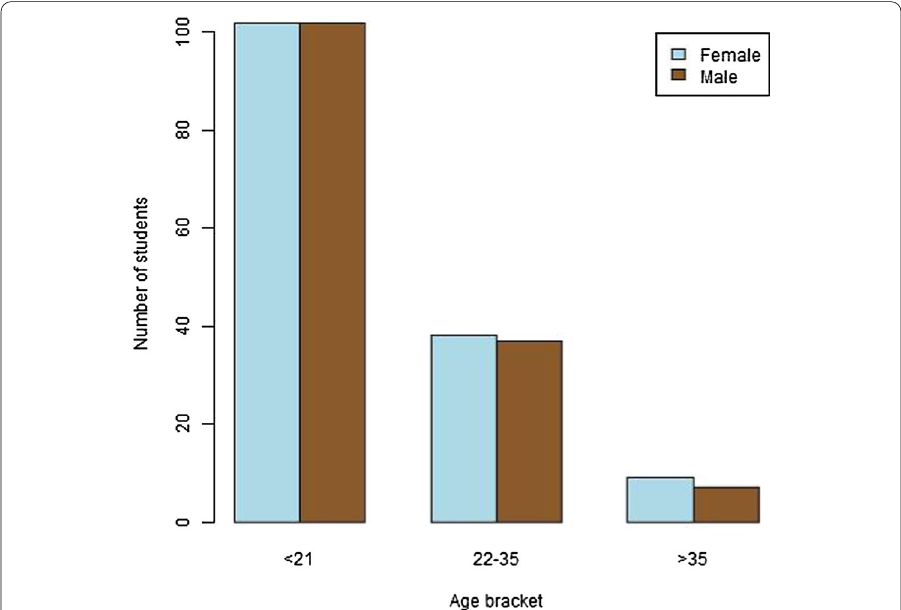
Fig. 1 Barplot showing the numbers of male and female students in each age